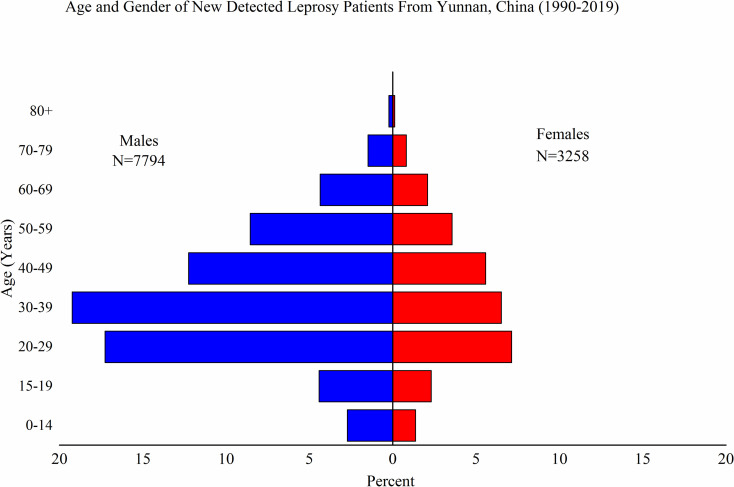
Demographic Profile of Newly Detected Leprosy Patients from Yunnan, China, 1990–2019.Age and sex of newly detected leprosy patients from Yunnan, China (1990–2019).